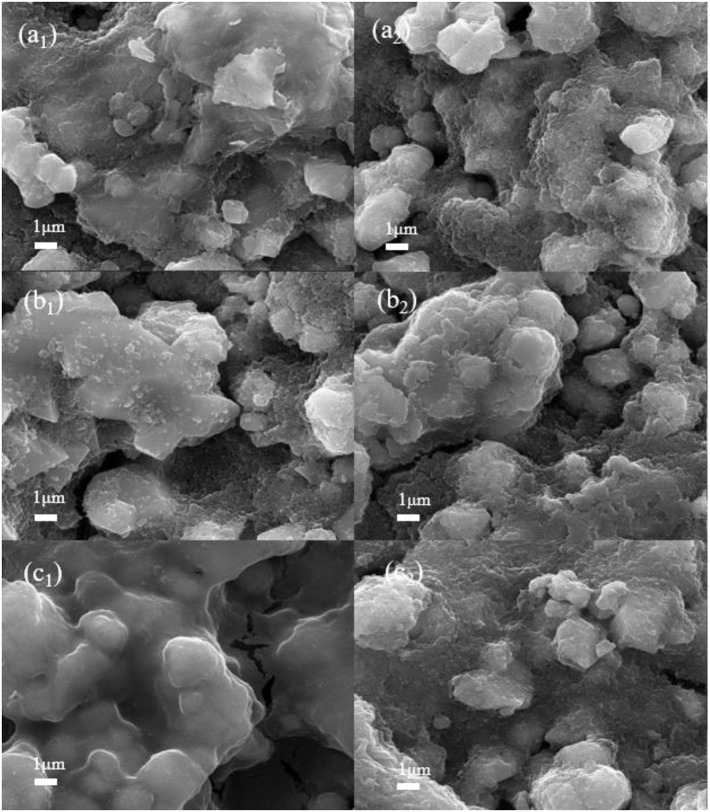
SEM images of LiNi0.5Mn1.5O4 cathode surface of three electrolytes after 10 and 100 cycles: (a1,a2) 1 mol L−1 LiPF6-EC/EMC; (b1,b2) 2 mol L−1 LiBF4-GBL/ADN; (c1,c2) 2 mol L−1 LiBF4-GBL/ADN+2%FEC.